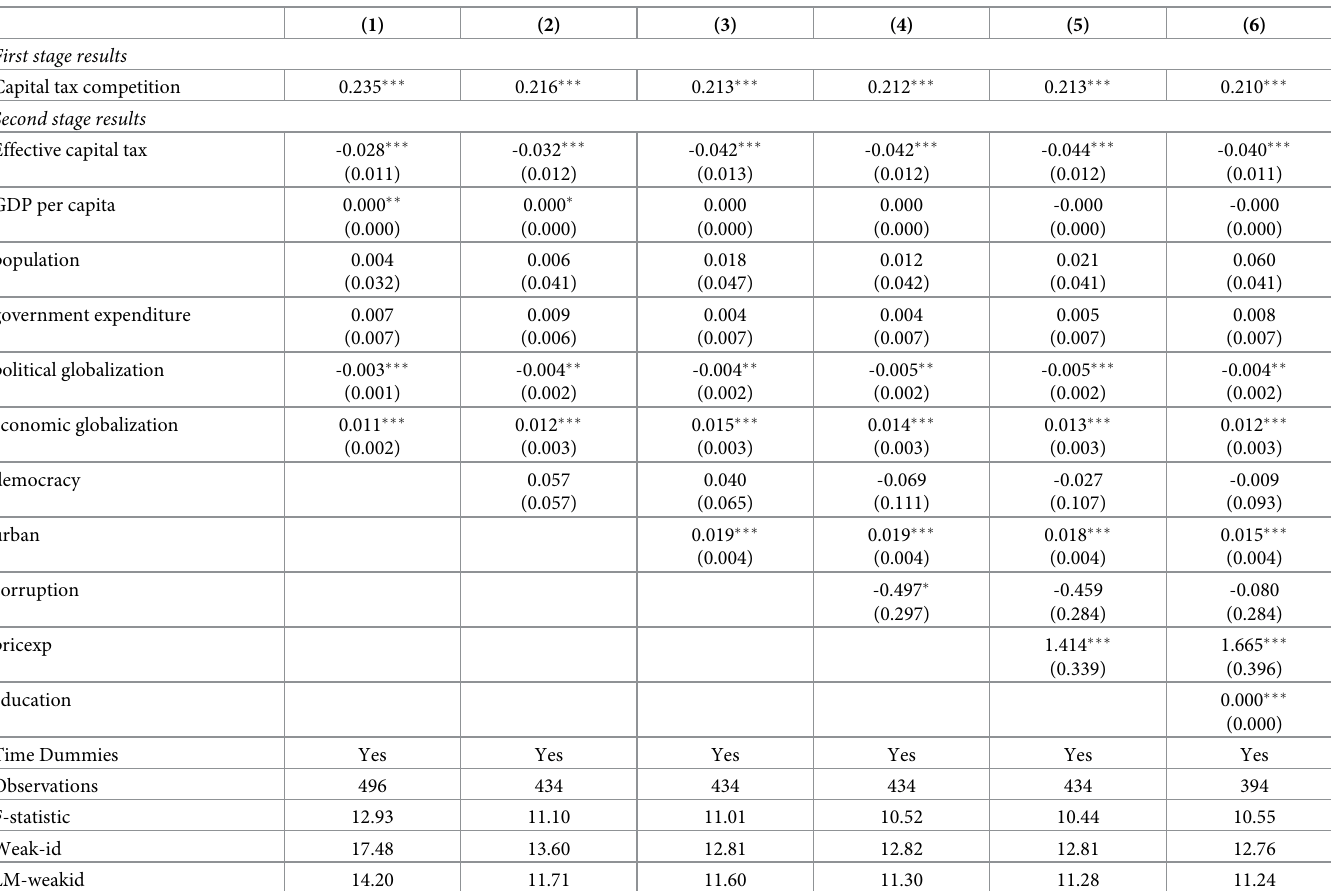
Table 2. The impact of taxation on economic sophistication: Effective capital tax